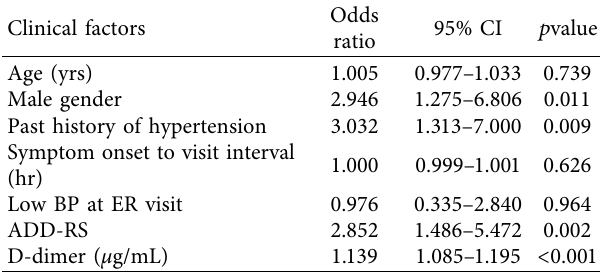
Table 2: Multivariate analysis of clinical factors associated with acute aortic